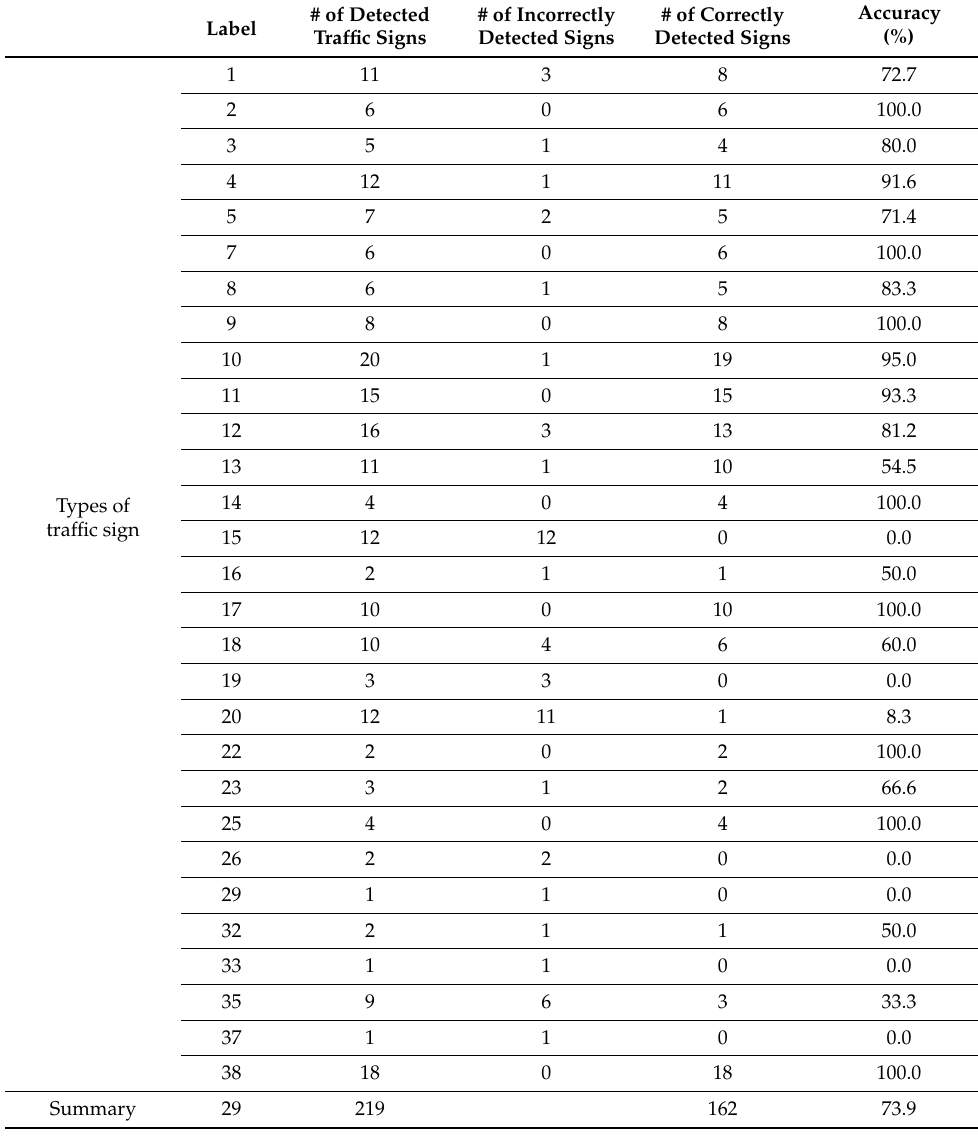
Table 4. Traffic sign recognition results of the FSADD for the GTSDB